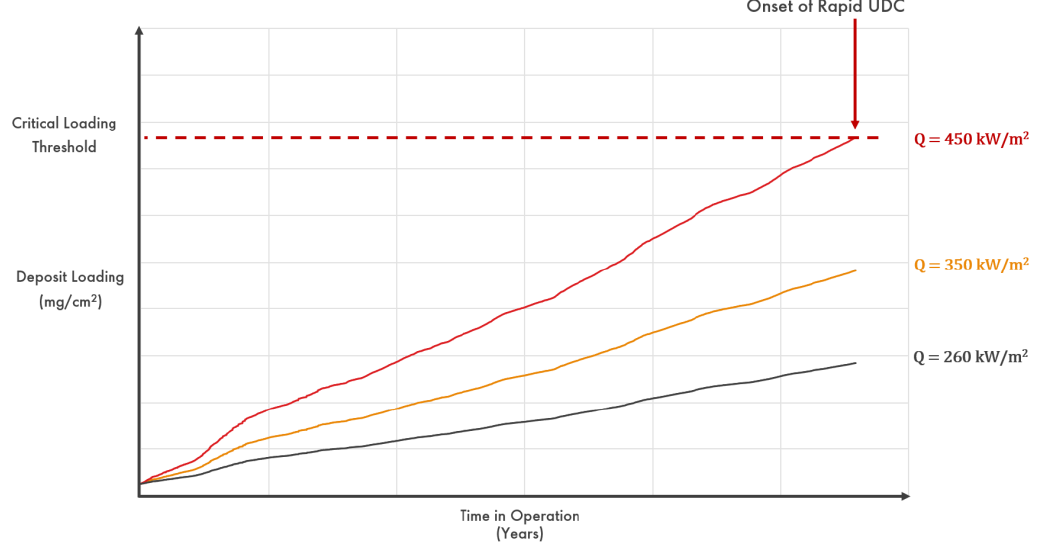
Figure 3. Schematic showing trending of boiler tube deposit loading data for different heat flux (Q) values, with the red dotted line indicating the critical value before which cleaning must be carried out to avoid the onset of UDC.